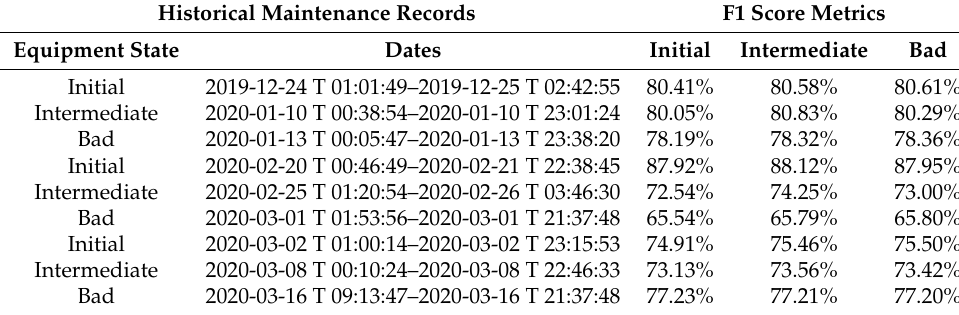
Table 6. LSTM-autoencoders F1 score metrics.